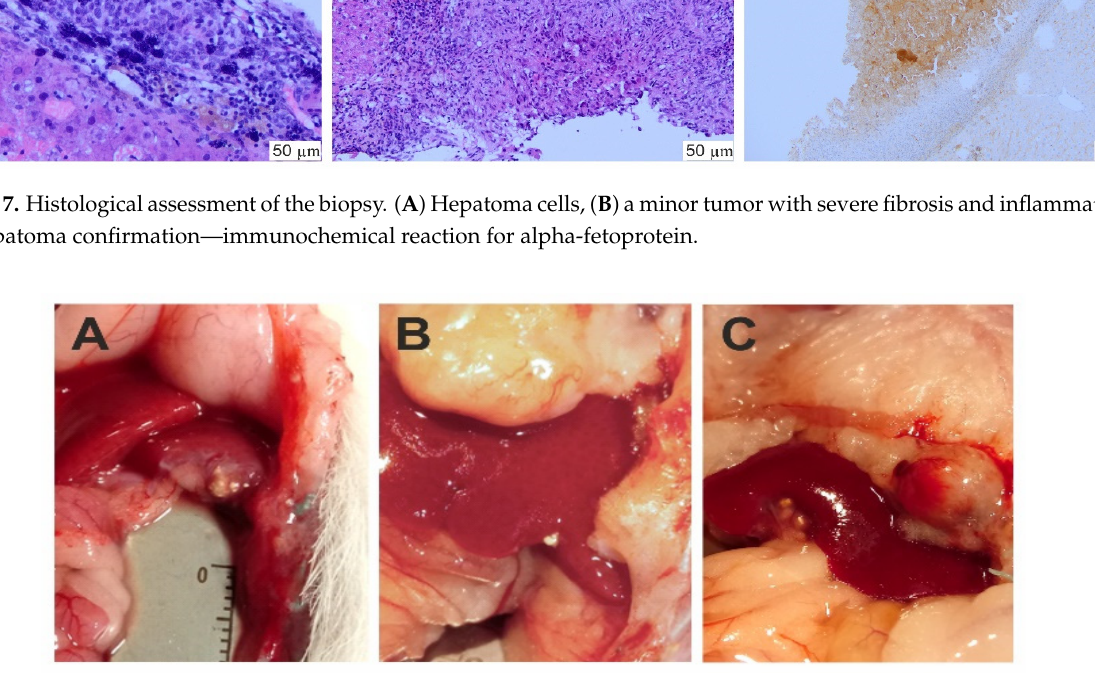
Table 2. Summarized results of the surgical examination of rats after SOR and SOR-releasing nanocarriers administration. Group ( n )